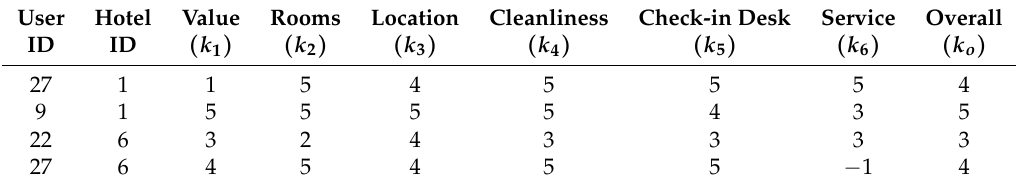
Table 3. Sample dataset for hotel